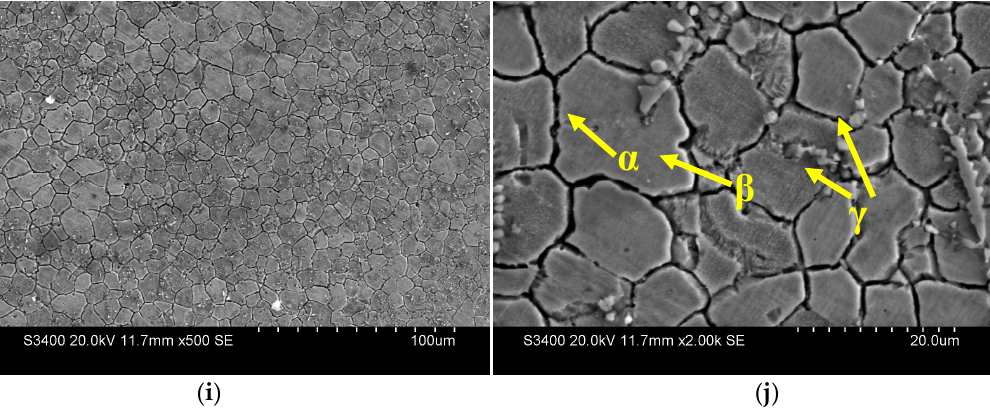
Figure 2. Cross ‐ sectional SEM images of FeCoCrNiAlTi x HEA coatings. ( a , b ) x = 0; ( c , d ) x = 0.25; ( e , f ) x = 0.5; ( g , h ) x = 0.75; ( i , j ) x = 1. Table 1. The chemical composition (at.%) in different regions, as marked in Figure 2.